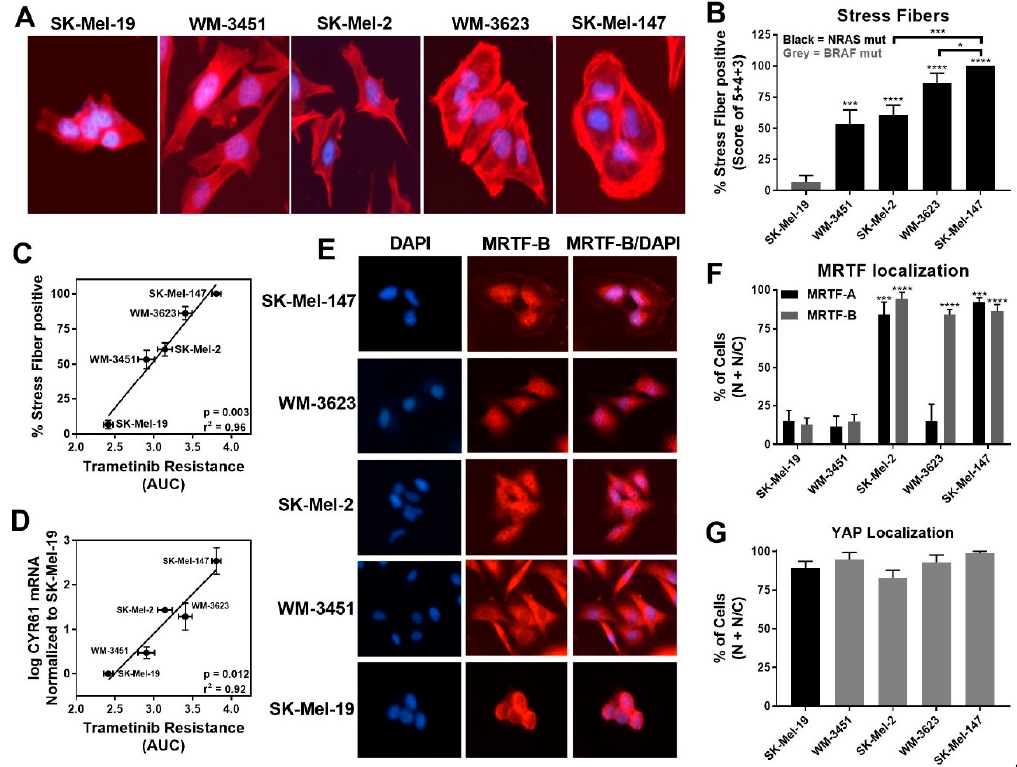
Figure 2. MRTF-pathway activation correlates with increased trametinib resistance. ( A ). Actin staining was assessed on the melanoma cell line panel using fluorophore-conjugated phalloidin toxin. ( B ). For stress fiber quantification, a score between 1 and 5 as described in Methods was utilized, and the percentage of cells scored as 3, 4, and 5 is presented as stress fiber-positive for each cell line (results are expressed as the mean ± SEM, n = 3, * p < 0.05, *** p < 0.005, **** p < 0.001 vs. SK-Mel-19 or SK-Mel-147). ( C ). The percentage stress fiber positivity correlates with trametinib resistance as assessed by the AUC for the trametinib concentration response curve (r 2 = 0.96, p = 0.003, Pearson correlation coefficients, GraphPad Prism). ( D ). CYR61 mRNA levels (n = 3) also correlate with trametinib resistance. (r 2 = 0.92, p = 0.012, Pearson correlation coefficients, GraphPad Prism). ( E ). Immunolocalization of MRTF-B in melanoma cell lines. DAPI is used to stain nuclei. Images for MRTF-A in Figure S2. ( F ). Images were quantified by scoring individual cells as exclusively nuclear (N), exclusively cytosolic (C), or even distribution (N/C) of MRTF-A (black bars) or MRTF-B (gray bars). Counts are from three independent experiments with at least 100 cells scored for each cell line (n = 3, *** p < 0.005, **** p < 0.001 vs. SK-Mel-19). ( G ). Cellular localization of YAP using immunofluorescence was determined (n = 3, Figure S2B) and quantified as described for MRTF isoforms. No significant difference was observed across the melanoma cell